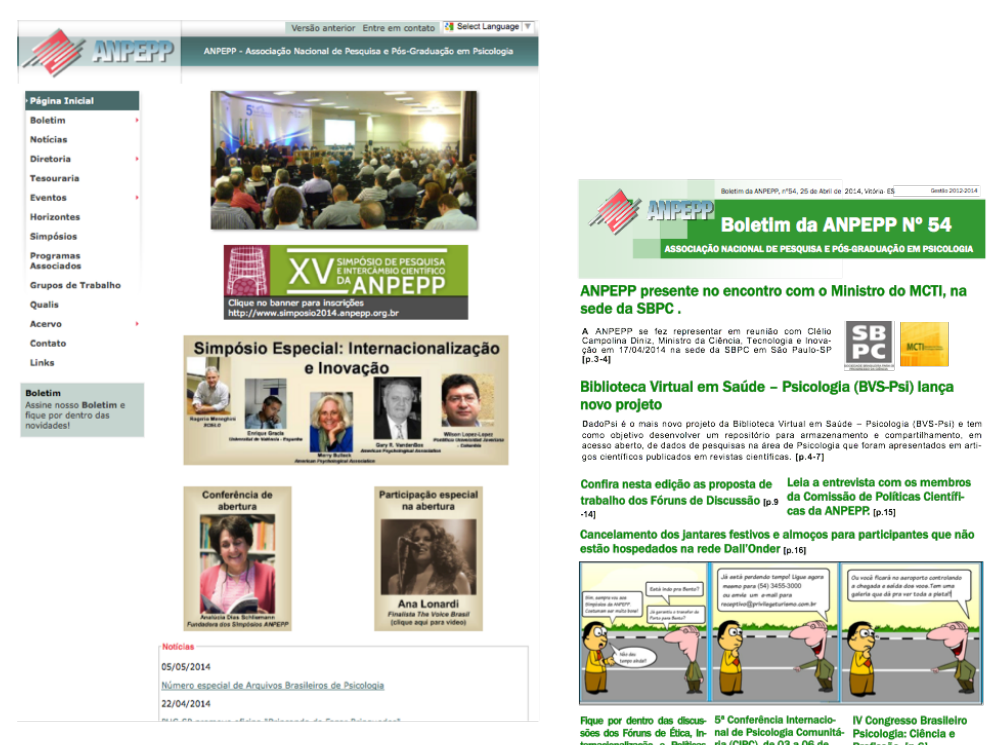
Figure 3 . Pages from ANPEPP’s site: